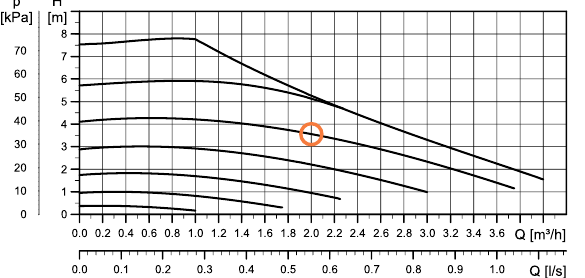
Figure 7. Graph of a pump curve extracted from the data-sheet of Grundfos-UPM3 . The performance of PWM controlled pumps is measured with A profile (heating) at eight PWM values: 5% (max.), 20%, 31%, 41%, 52%, 62%, 73%, 88% (min.), PWM regulates the speed of the pumps ω